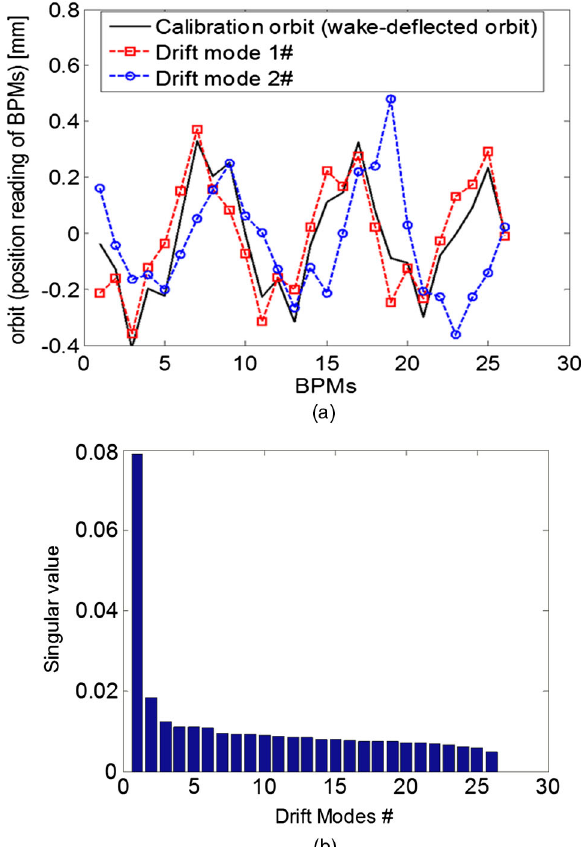
FIG. 7. (a) Patterns of wake-deflected orbit and drift orbits. (b) SVD Eigenvalue (strength) of all drift modes.